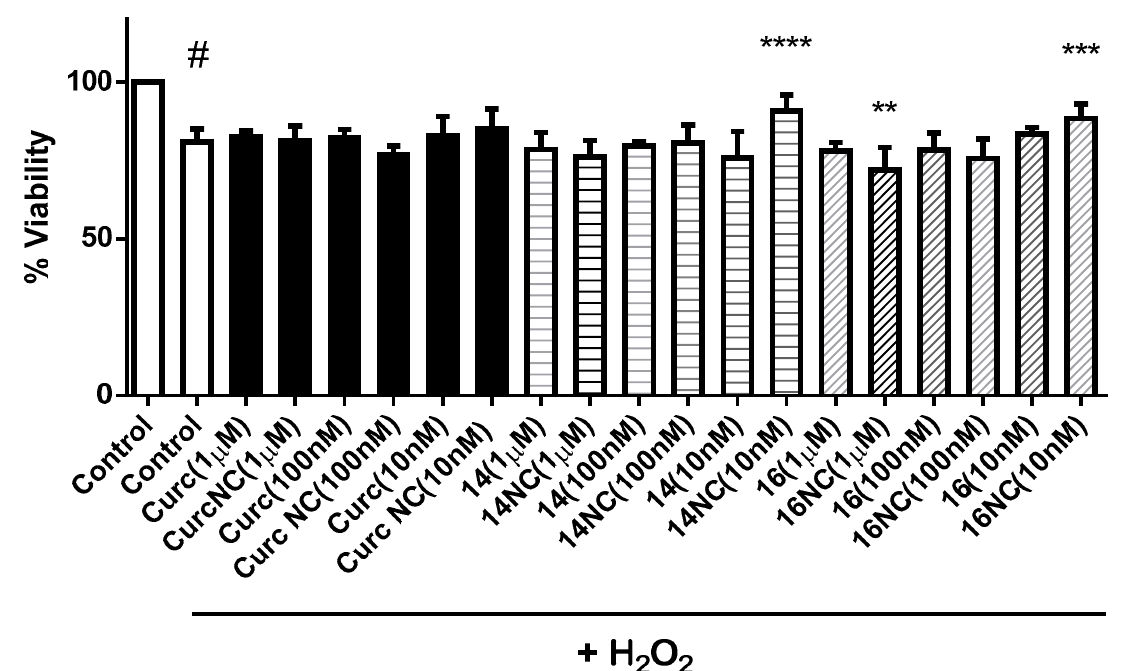
Figure 3. Neuroprotective effects of curcumin and curcumin–coumarin hybrid analogues 11 – 18 (10 μ M) on SH ‐ SY5Y cells. The results are expressed as % viability versus the control group (treated with DMSO 1%, or DMSO 1%, and H 2 O 2 100 μ M). Each value is the mean ± s.e.m of at least five experiments. # p < 0.0001 versus the control group without H 2 O 2 treatment. * p < 0.05, ** p < 0.005 versus DMSO + H 2 O 2 treated group.